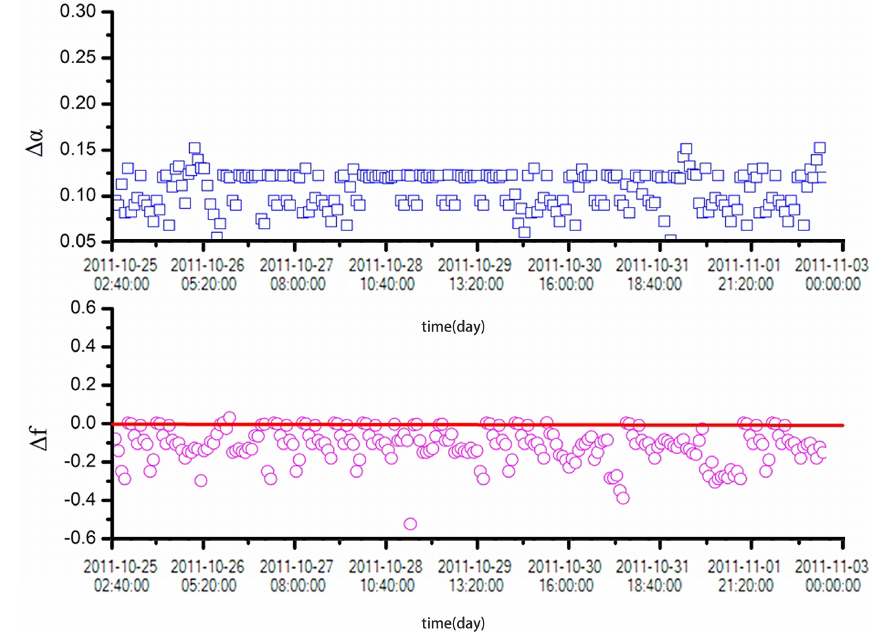
Figure 10. Temporal multifractal spectrum of EMR in non-danger